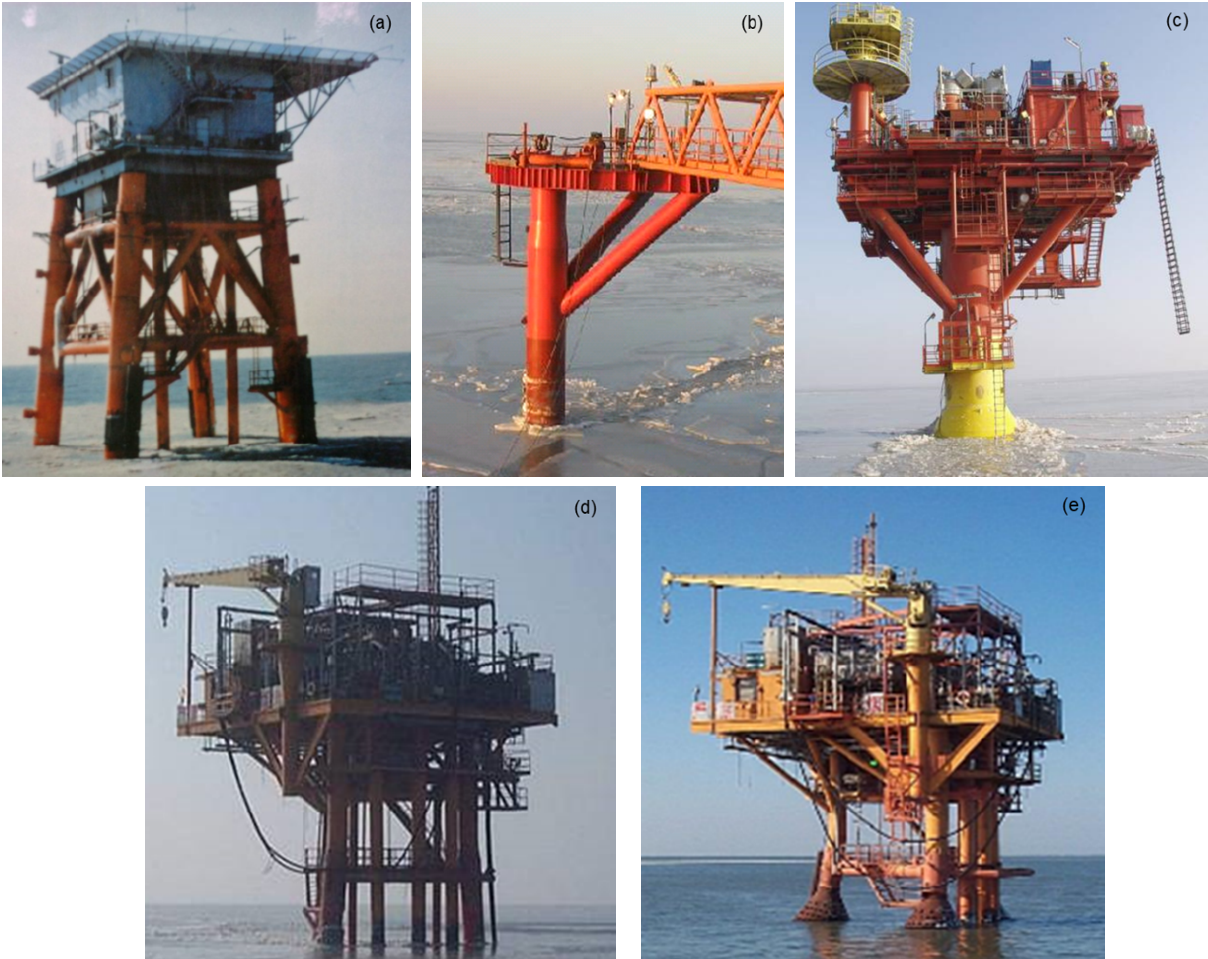
Figure 2. Main structural forms of jacket platforms in Liaodong Bay: (a) a four-legged oil production platform (built in 1987), (b) a one- legged auxiliary platform (built in 1999), (c) a one-legged oil production platform (built in 2003), (d) a three-legged upright pile production platform (built in 1997), and (e) a three-legged upright pile production platform with cones (built in 2000). All of these images were created by Dalian University of Technology and the China National Offshore Oil Corporation.